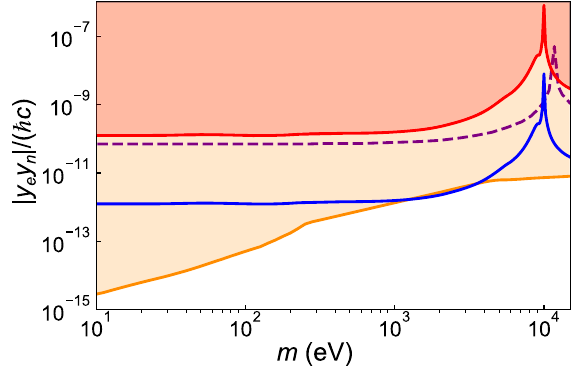
y FIG. 8. Product of couplings j y of a new boson as a e n j function of the mass m . The red line represents the upper bound of the coupling with the 95% C.L. (see main text for details). For comparison, the constraint from electron anomalous magnetic moment ( g − 2 ) measurements [44,45] combined with neutron scattering measurements [46 – 48] is shown as the orange shaded region. The purple dashed line shows the upper bound from the Ca þ analysis in Ref. [11]. The blue line shows the constraint and δ h r 2 i A 0 A are which is obtained if the uncertainties of ν A 0 A α ð β Þ improved by factors of 10 2 and 10,